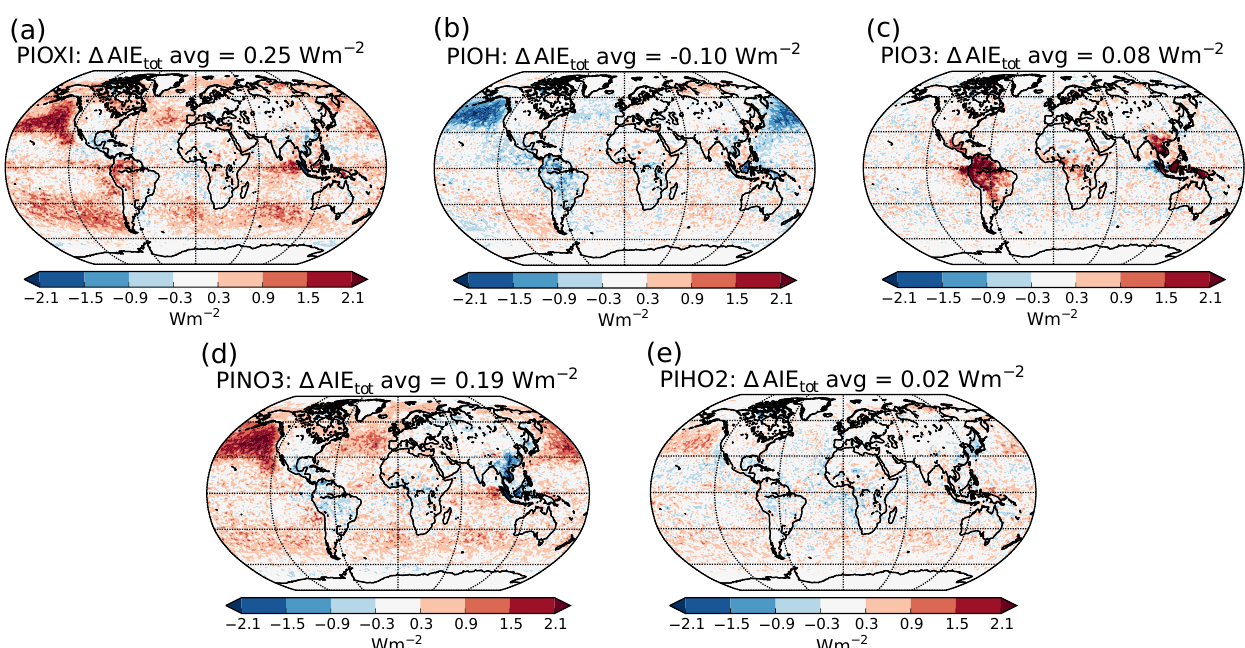
Figure 12. Differences in total aerosol indirect effect between the PI simulation with (a) PIOXI, (b) PIOH, (c) PIO3, (d) PINO3, (e) PIHO2 and the original PI simulation with only PD oxidants.